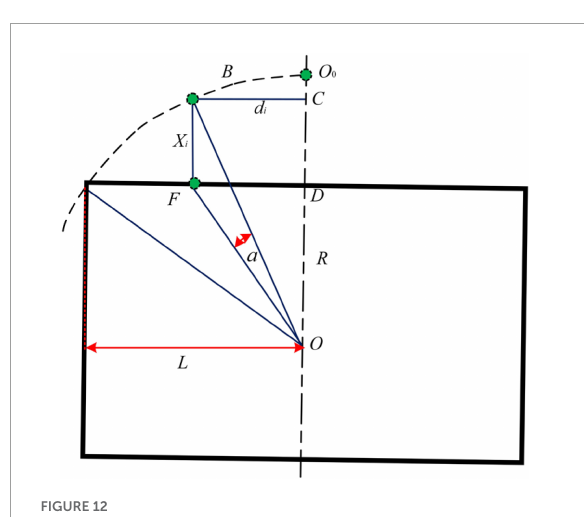
FIGURE12 An analysis diagram of distance adjustment of a photoelectric switch detection point at each position.